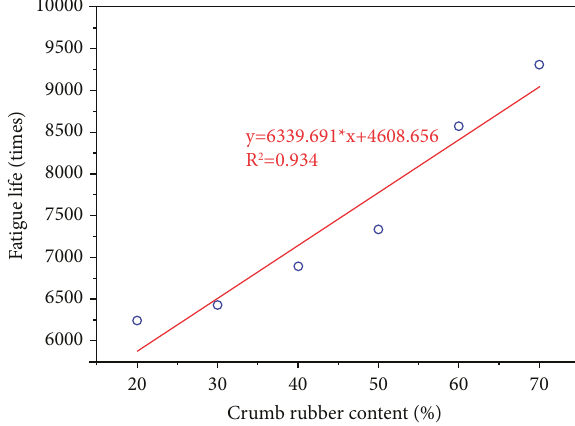
Figure 15: Effect of crumb rubber content on fatigue life.